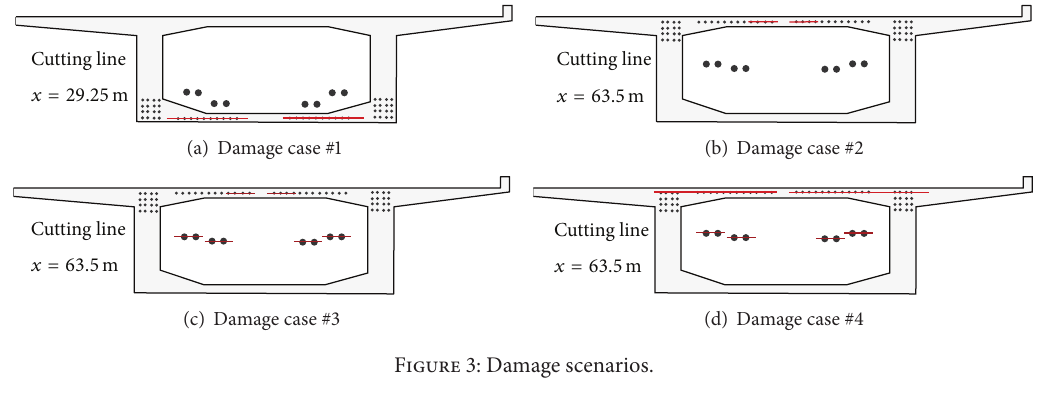
Figure 3: Damage scenarios.